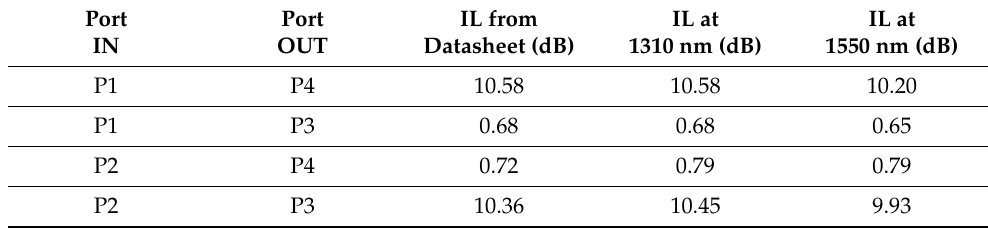
Table 2. Insertion loss of the coupler